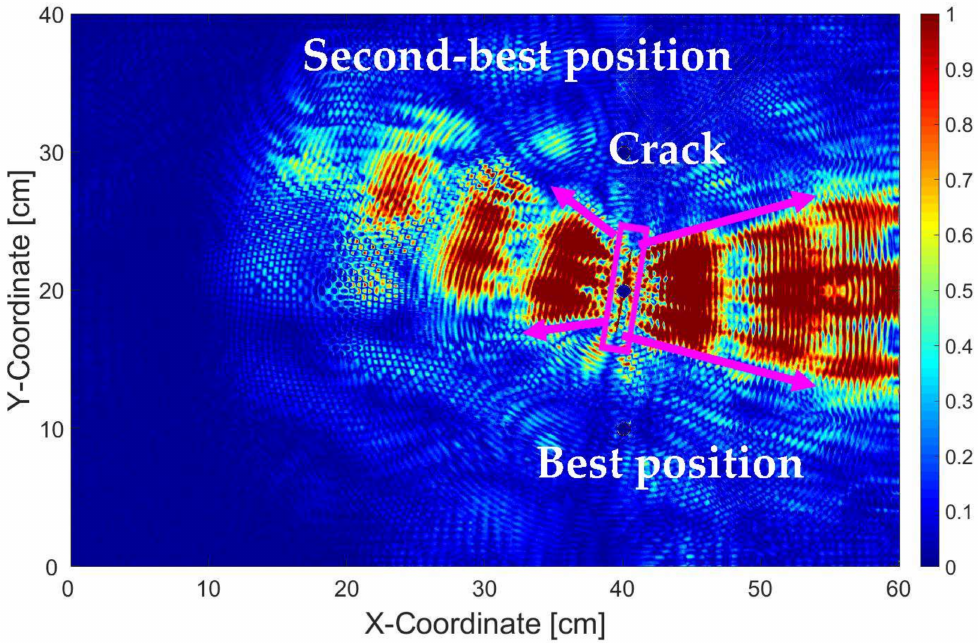
Figure 9. Fused image of differential images of 60 mm crack with 8 ◦